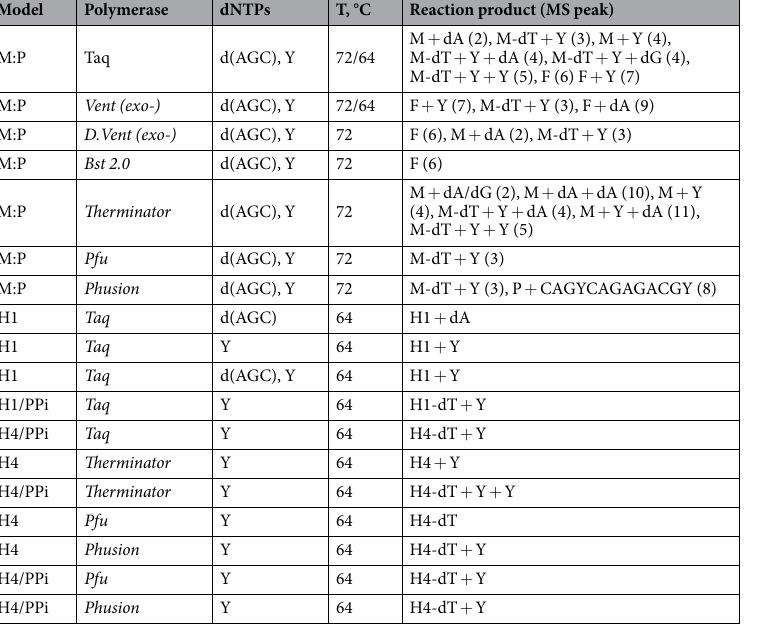
Table 1. Products of polymerase-assisted terminal modification reactions with extendable and non-extendable